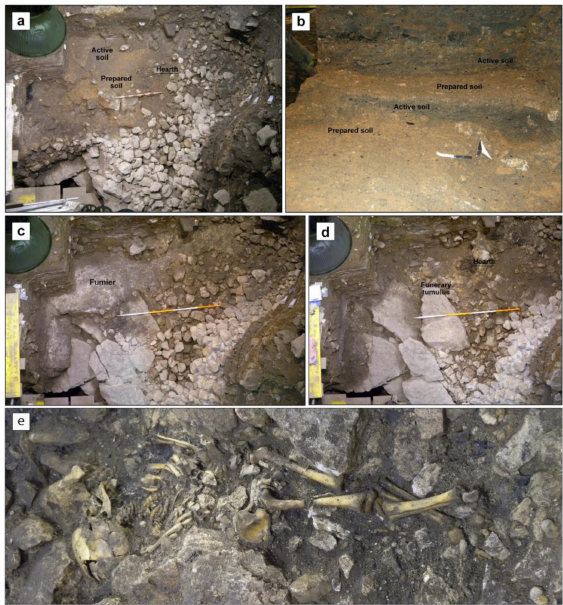
Figure 3. Different archaeological contexts of the Chalcolithic levels of El Portal ó n de Cueva Mayor site: ( a ) General view during the excavation of a prepared floor and active soils from the stabling phase. Note the overlapping disposition of these units in relation to the limestone blocks of the funerary tumulus from the previous phase; ( b ) detailed view of the alternation of prepared clay floors (orange) and active soils (dark) from the habitat/stabling context; ( c ) partially excavated white ash layer (fumier) covering the funerary tumulus; ( d ) general view of the funerary tumulus; note the basal large limestone blocks which originated from a collapse of the cave roof; ( e ) an example of the human remains contained in the funerary tumulus corresponding to an intact burial of a 6-year-old